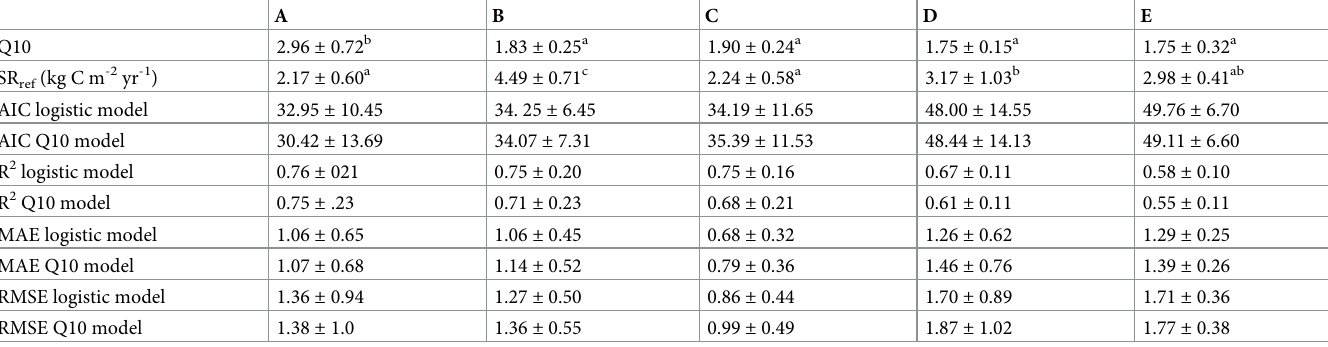
Table 4. Mean values of Q10 (temperature sensitivity) and SR ref (soil respiration at the temperature of 10˚C) for each site (A, B, C, D and E).